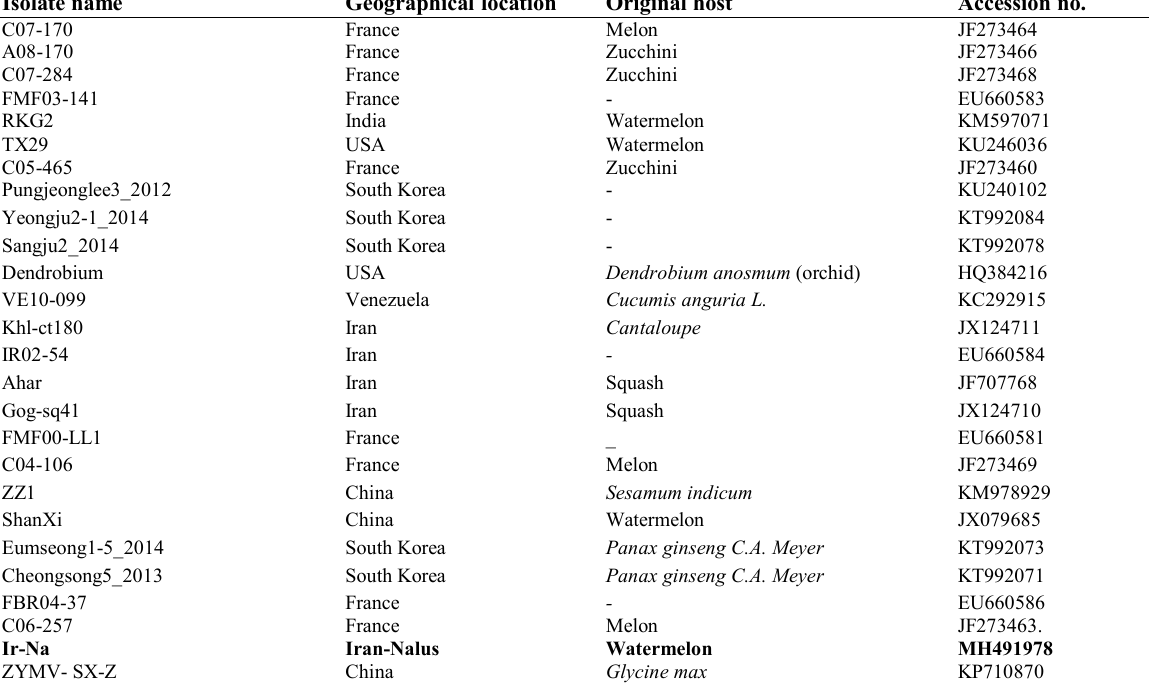
Table 4 . Name and origin of WMV isolates included in the phylogenetic analysis and accession numbers of the newly- generated sequence. The isolate obtained in this survey is in bold. Isolate